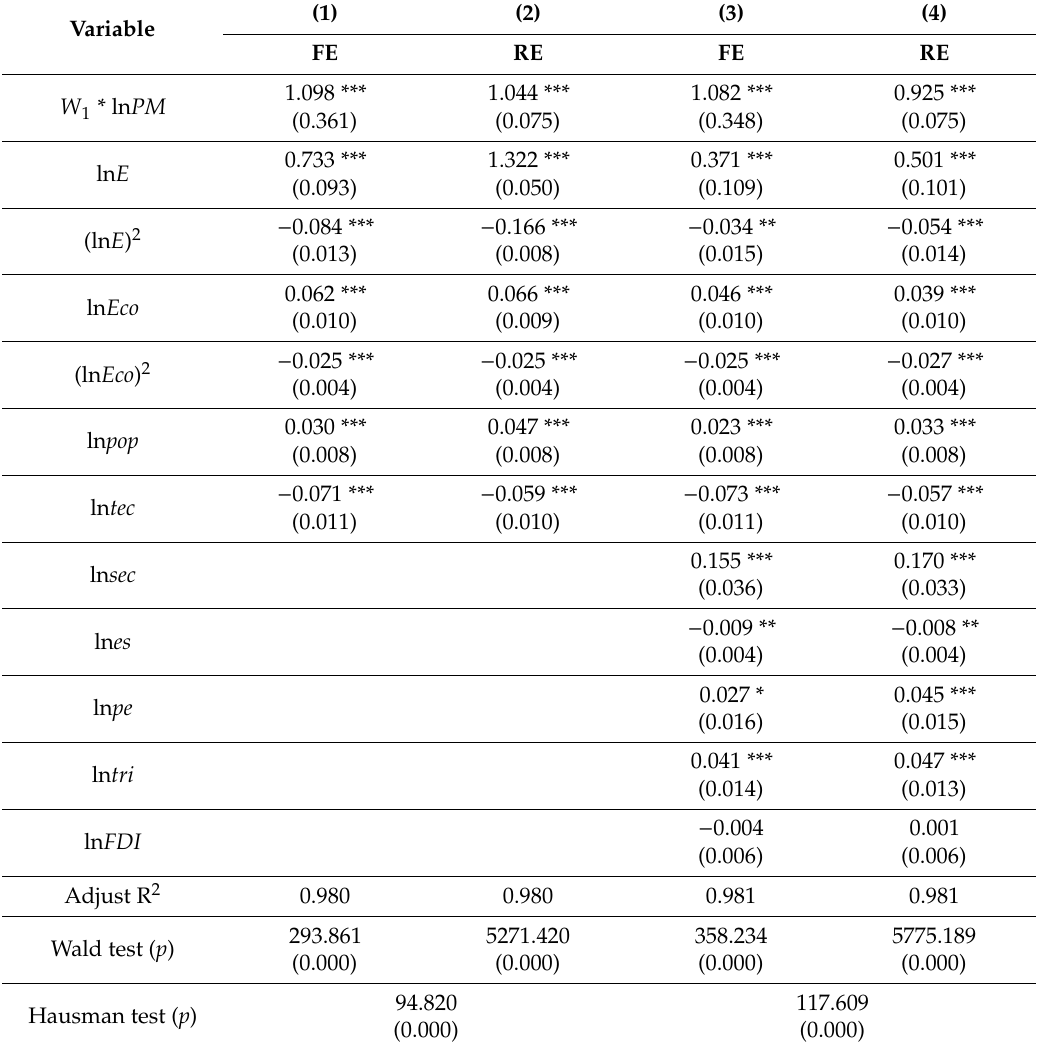
Table 2. Benchmark